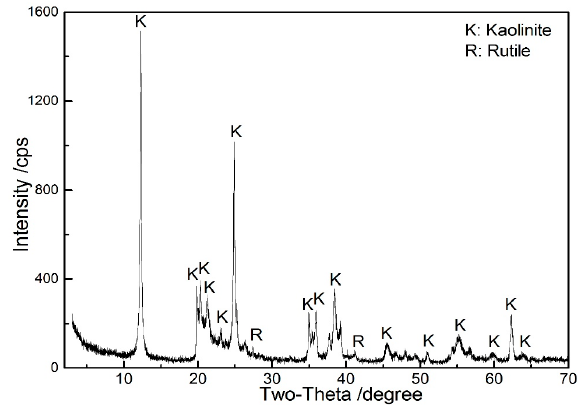
Figure 1. XRD pattern of kaolinite raw ore.